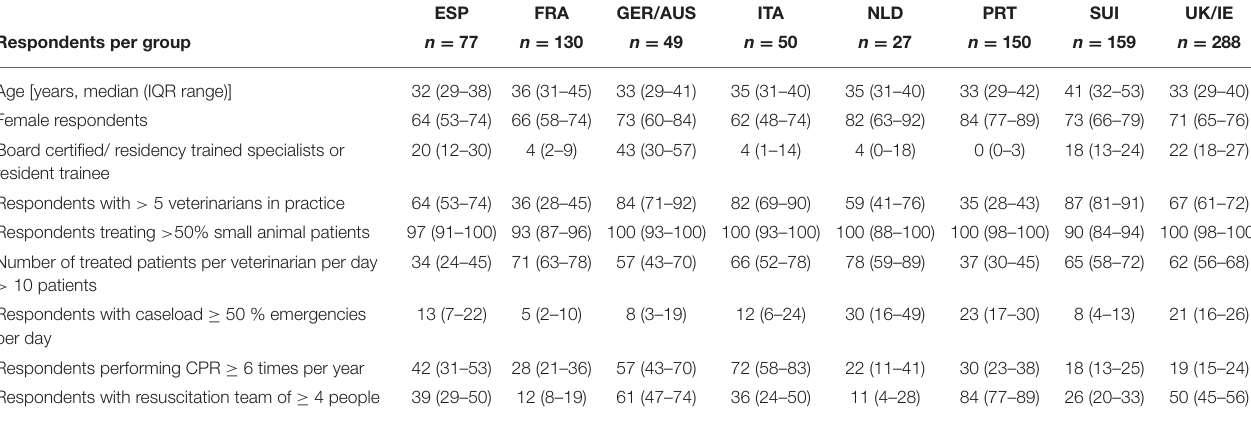
TABLE 1 | Demographic information and clinical environment characteristics of survey respondents across Western Europe by